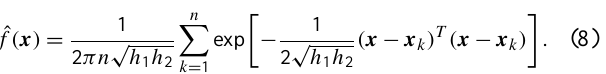
Fig. 2. The leading two EOFs of JJAS detrended SLP anomalies over the Asian summer monsoon region. The percentage of ex- plained variance of the EOFs are also shown. Units are 26 Fig.2. TheleadingtwoEOFsofJJASdetrendedSLPanomaliesovertheAsiansummermonsoon region. The percentageofexplainedvarianceoftheEOFsarealsoshown. Unitsarearbitrary. 25